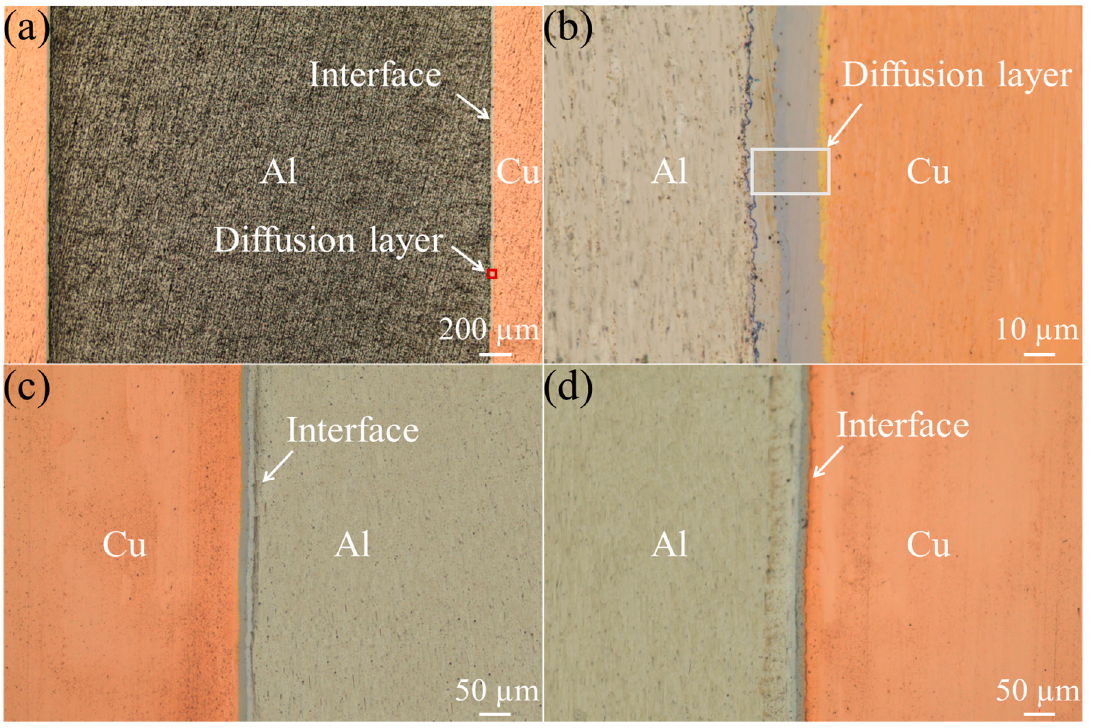
Figure 5. The bonding interface and diffusion layer condition of the composites. ( a ) Microscopic drawing of the sample. ( b ) Morphology of Cu/Al diffusion layer. ( c , d ) Microscopic views of Cu/Al upper and lower interfaces.